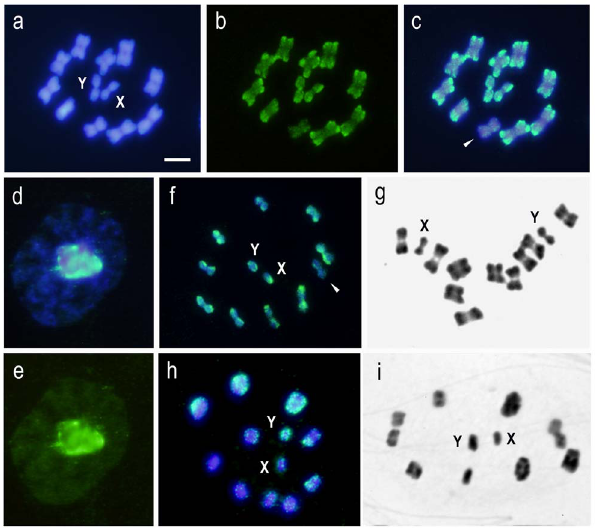
Figure 1. Self-GISH using three genomic DNA (gDNA) probes: Triatoma delpontei (TD) (male or female) and Triatoma infestans (TI) (Andean group) on own chromosomes. Bar 5 5 m m. (a-b-c) TD gDNA on TD chromosomes. Metaphase I (2n 5 20A + XY). (a) DAPI staining. (b) FITC. (c) Merged. Hybridization signals appear scattered on all chromatin. Furthermore, strongest signals are preferably located at one chromosomal end on nine of the ten autosomal bivalents. Both sex chromosomes (X and Y) appear almost entirely labeled. The bivalent without signal is pointed out by arrowhead. (d–e) TD gDNA on TD. Early male meiotic prophase. (d) DAPI staining. (e) FITC. A large heteropycnotic chromocenter appear with a strong hybridization signal and the rest of the chromatin with weaker signals. (f) TD gDNA (female) on TD chromosomes. Metaphase II (2n 5 20A + XY). Terminal regions of 9 autosomal pairs and both sex chromosomes, including the Y chromosome, appear strongly labeled. The autosomal pair without strong hybridization signals is pointed out by arrowhead. (g) TD. C-banding. Metaphase I. All autosomal bivalents (10) show C-blocks in only one chromosomal end. Both sex chromosomes (XY) appear almost entirely. C-heterochromatin distribution similar as observed with GISH in (c). (h) TI (Andean group) gDNA on TI (Andean group) chromosomes. Metaphase I (2n 5 20A + XY). Six autosomal bivalents show hybridization signals with different intensity and size. The Y chromosome appears almost entirely labeled while that X chromosome shows a small hybridization region. (i) TI (Andean group). C-banding. Metaphase I. Seven to nine autosomal bivalents appear heterochromatic with C-blocks of different size in one or both chromosomal ends, while X and Y sex chromosomes are almost entirely